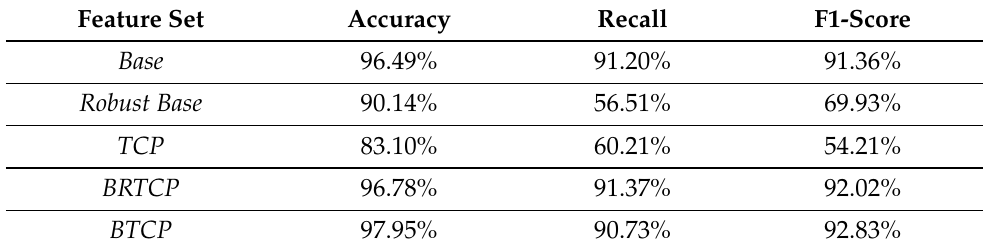
Table 5. Model performance—SVM.